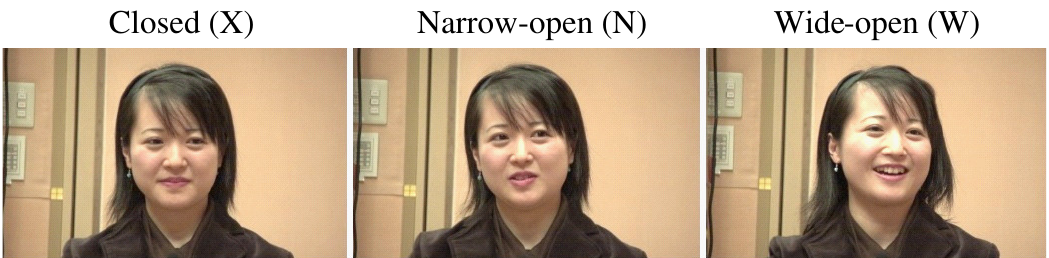
Figure 2. Sample images showing the degree of mouth-opening. From the left, these are images when mouth-opening is closed ( X ), narrow-open ( N ) and wide-open ( W